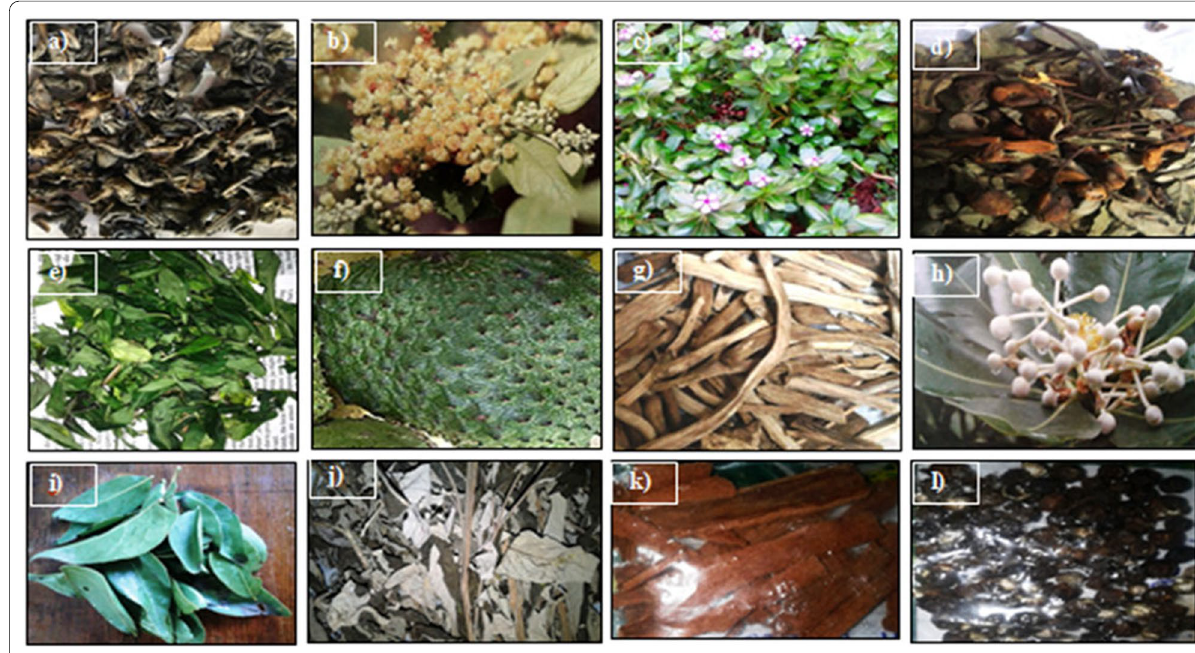
Fig. 1 The plant samples used in the study, a Camellia sinensis , b Guazuma ulmifolia , c Catharanthus roseus , d Cassia auriculata , e Andrographis paniculata , f Annona muricata , g Asparagus racemosus , h Calophyllum inophyllum , i Aegles marmelos , j Justicia gendarussa , k Cinnamomum aromaticum , l Piper nigrum